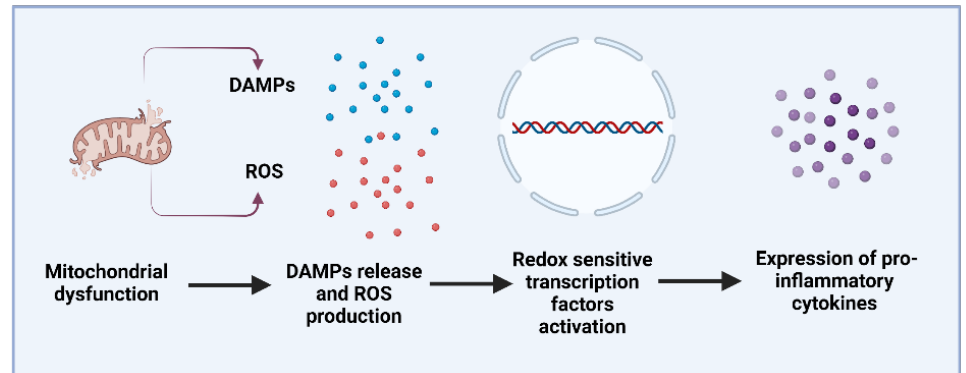
Figure 2. Mitochondria has a signalling hub for inflammatory responses. Mitochondrial dysfunction leads to an overproduction of ROS and release of DAMPs that can activate redox sensitive transcrip- tion factors such as transcription factor nuclear factor κ B (NF- κ B) and enhance the expression of inflammatory genes leading to the increase in pro-inflammatory cytokines and mediators. Created by Biorender.